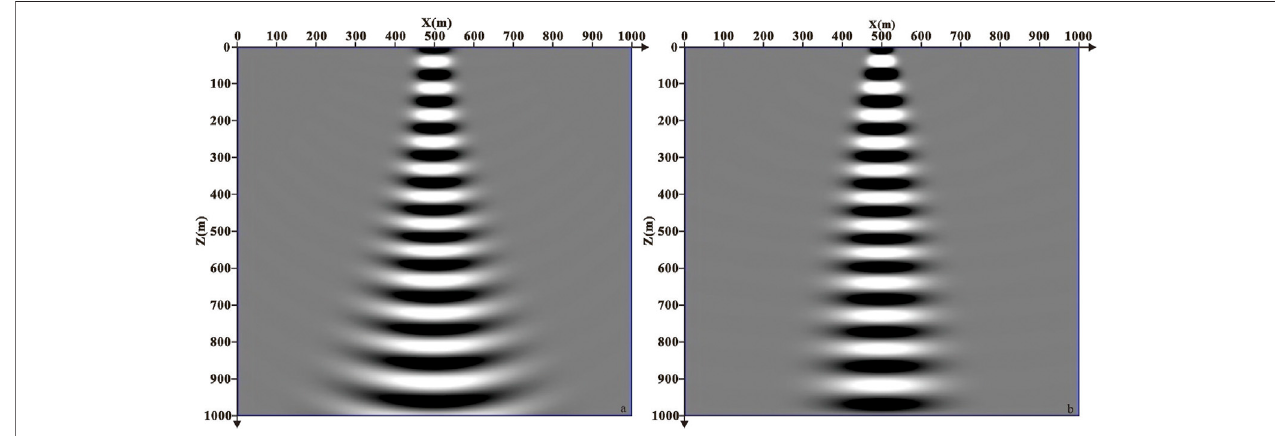
FIGURE 1 | Comparison diagram of beam propagation in the constant velocity model. (A) Gaussian beam and (B) Fresnel beam.